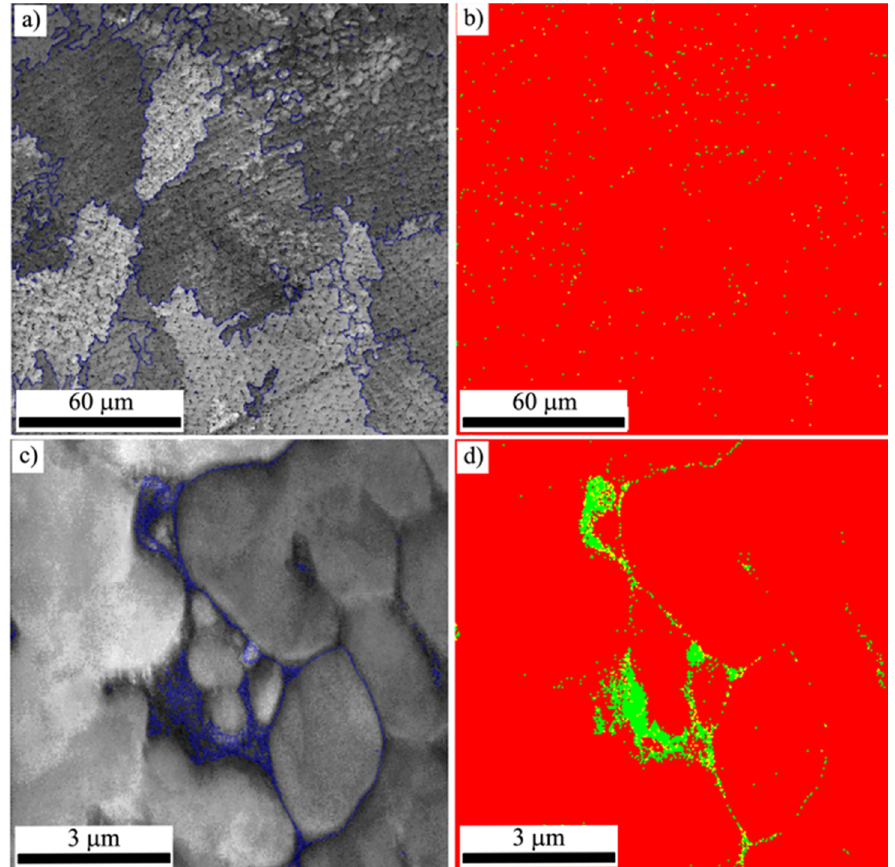
Figure 6. EBSD band contrast map ( a , c ) and maps of a phase distribution for sample #4. In ( a , c ), the high-angle boundaries (>15°) (grains boundaries’ rotation angle) are marked by blue color. In ( b , d ), red color indicates the cobalt austenite phase, and green color indicates the CrCo solution with cobalt–tungsten carbides.